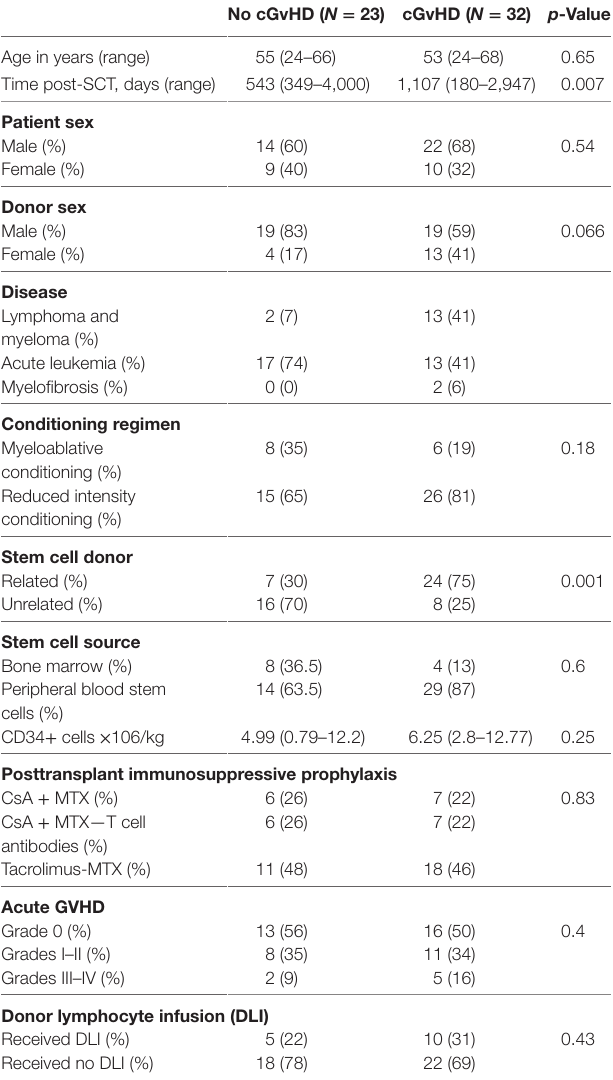
TaBle 1 | Patient, disease, and transplant characteristics.